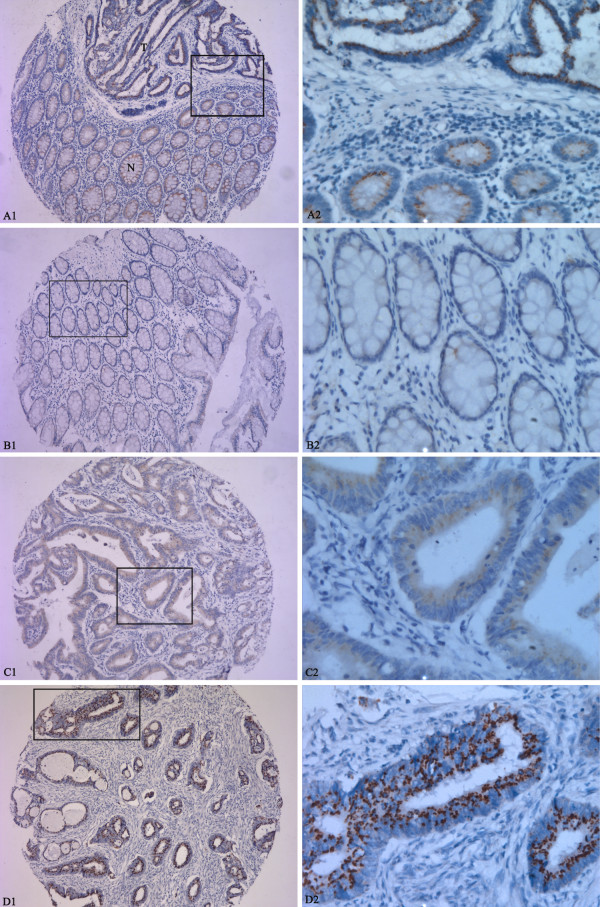
Immunohistochemical analysis of the expression of pMEK5 protein. pMEK5 expression was localized within the cytoplasm. A1 and A2, Elevated pMEK5 expression in the tumor cells of CRC tissue (T) compared with those of adjacent normal mucosa (N); B1 and B2, only weak staining of pMEK5 was detected in normal colorectal epithelial tissue; C1 and C2, moderately positive expression of pMEK5 in CRC without distant metastasis; D1 and D2, strongly positive expression of pMEK5 in CRC with distant metastasis (Left panels, ×100, right panels, ×400).